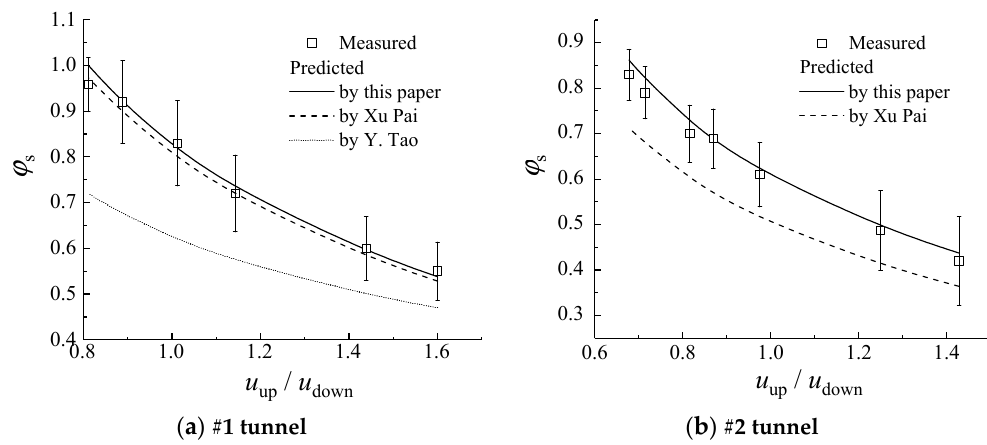
Figure 12. Comparison of predicted φ s with measured results.